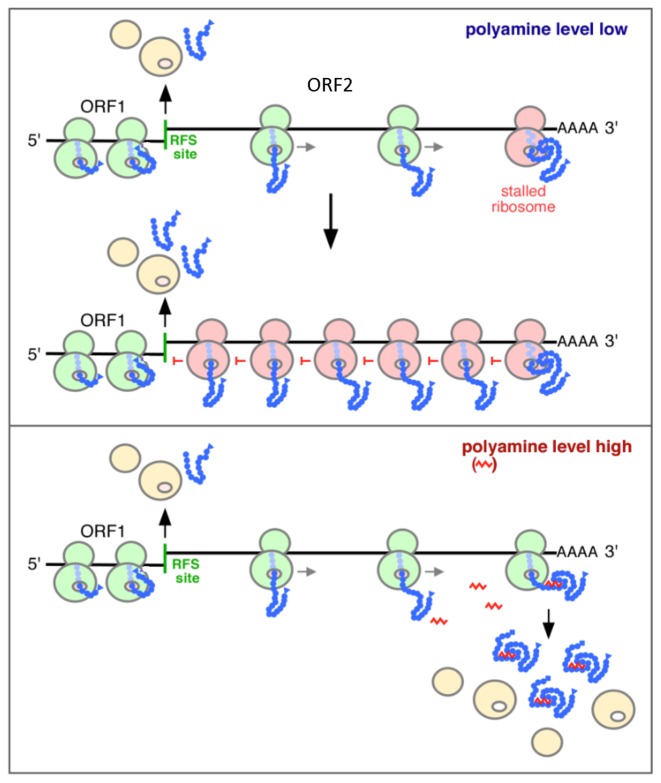
Scheme for S. cerevisiae antizyme mRNA +1 frameshifting. The top box represents low cellular polyamine concentrations, where ribosomes pause at the frameshifting site (RFS) with the ORF1 stop codon in the ribosomal A-site. Some terminate, while others continue translation in the +1 frame. An inhibitory element near the N-terminus of the nascent peptide, encoded near the start of ORF1, keeps frameshifting rates low. When a ribosome approaches the 3′ end of ORF2, a newly synthesized part of the nascent peptide, causes this ribosome (pink) to stall. Following translating ribosomes (green) encounter the stalled ribosome and their movement is also blocked (line 2 with multiple pink ribosomes). When polyamine levels are high (lower panel) the nascent peptide encoded near the 3′ end of ORF2, binds polyamines and is then unable to cause stalling. This allows the ribosome containing it to proceed to termination and release of functional antizyme. Reprinted by permission from Macmillan Publishers Ltd: Kurian,L., Palanimurugan,R., Godderz,D. and Dohmen,R.J. (2011) Polyamine sensing by nascent ornithine decarboxylase antizyme stimulates decoding of its mRNA. Nature, 477, 490–494.